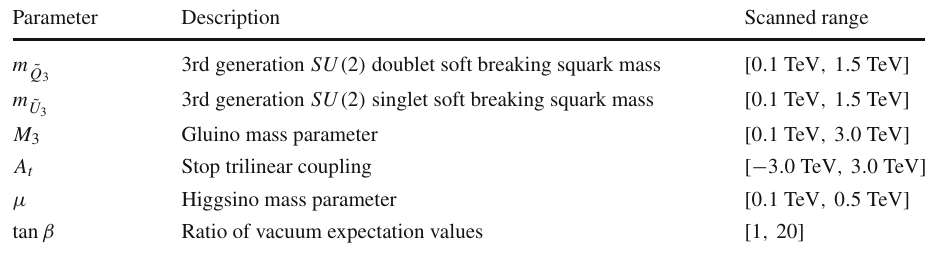
Table 7 The experimental analyses used in Ref. [76]. The ATLAS-CONF and CMS-SUS papers are only available as conference proceedings, the others are given by their arXiv number. The middle column corresponds to the final state of the respective search, and the third column shows the total integrated luminosity employed in this analysis. The fourth column gives the total number of signal